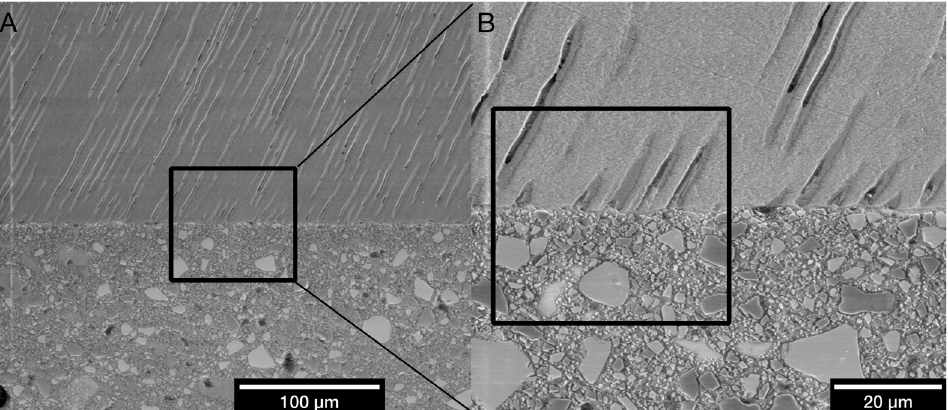
Figure 3. Exemplary area selection (PAN, DC) for semiquantitative analysis. ( A) Adhesive interface in lateral dentin at × 800 original magnification. Black square: Area for the micrograph at × 3000 original magnification. ( B ) Adhesive interface in lateral dentin at × 3000 original magnification for semiquantitative analysis. Black square: Area for the micrograph at × 6000 original magnification for exemplary descriptive depiction.